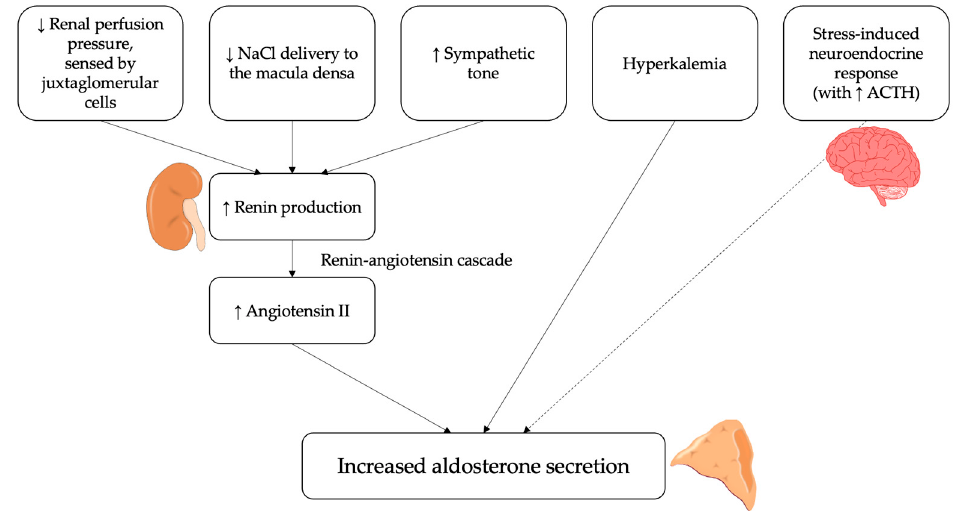
Figure 1. Physiological regulators of aldosterone secretion. Several stimuli can induce the release of aldosterone by the adrenal cortex via the renin-angiotensin system. These include a reduction in renal perfusion pressure, sensed by juxtaglomerular cells, a decrease in NaCl delivery to the macula densa and an increase in sympathetic activity. Moreover, hyperkalemia can directly stimulate aldosterone secretion from adrenal cortex. Finally, the adrenocorticotropic hormone (ACTH) can act as an aldosterone secretagogue, although it plays a minor role in its regulation.